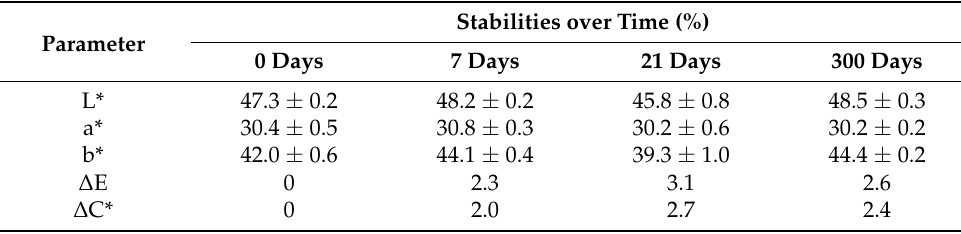
Table 4. Colour stability parameters (L*, a*, b*), cumulative difference in colour ( ∆ E), and